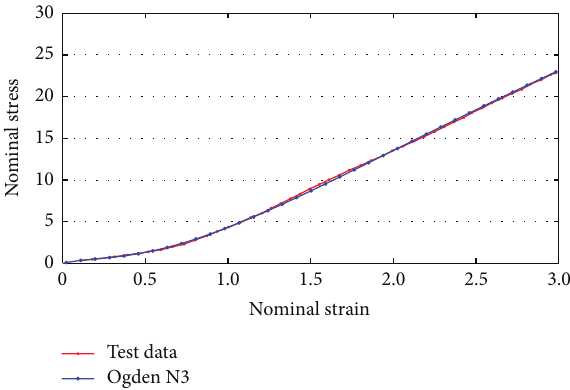
Figure 8: Curve fitting using a hyperelastic material model of ACL.